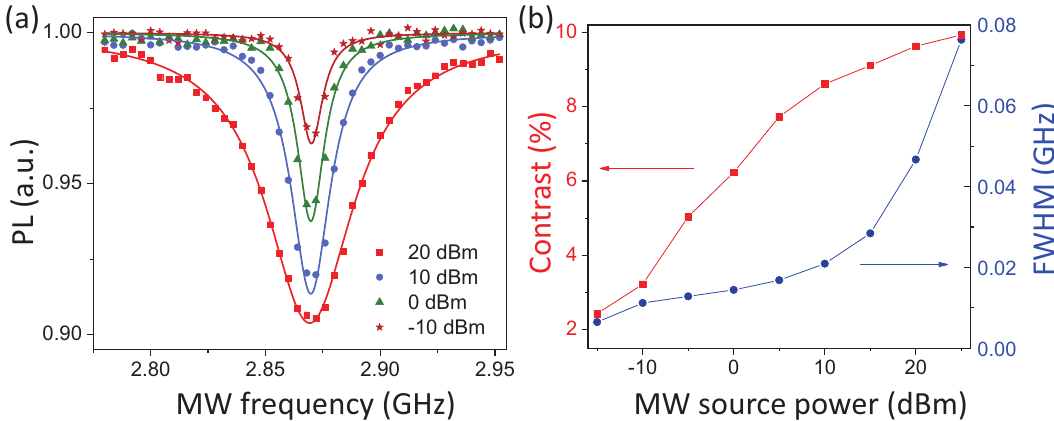
Figure 6. ( a ) ODMRspectra of Spot A in Figure 5b extracted with four different MW sources’ power fed in. The line width and dip contrast increase with the MW source power. ( b ) ODMR signal contrast (red square) and FWHM (blue dot) versus MW source power extracted from ODMR spectra of Spot A with different MW source powers fed